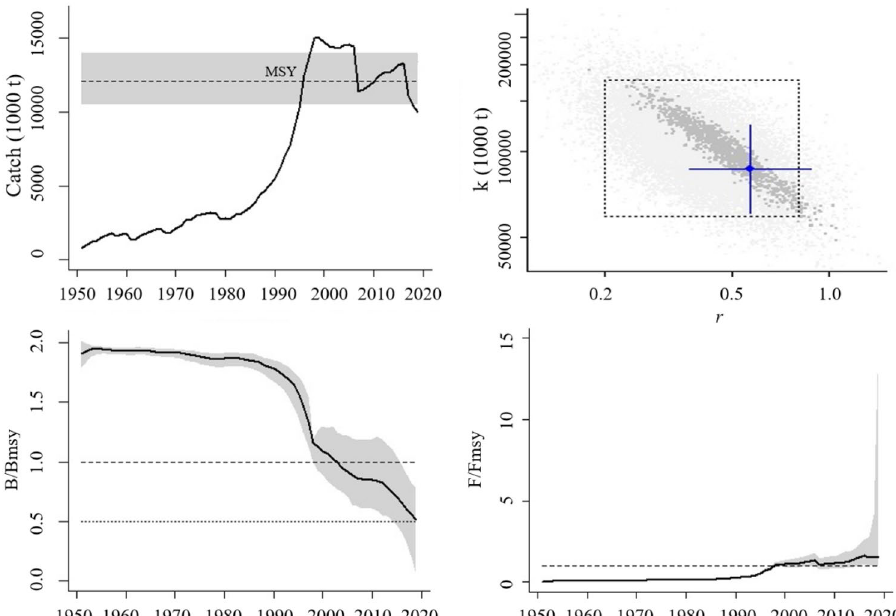
Figure 1. Results of the CMSY. The upper left panel shows catches relating to the MSY estimated by CMSY, with indication of 95% confidence limits (CL) in grey. The upper right panel shows the most probable r–k pair and its approximate 95% CL in blue. The lower left panel shows the development of relative total biomass ( B / B msy ), with the grey area indicating uncertainty. The lower right graph shows relative fishing mortality ( F / F msy